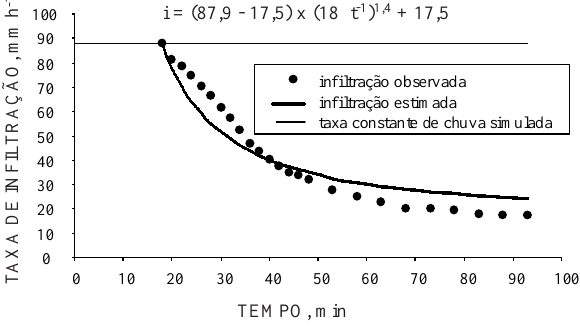
Figura 5. Taxas de infiltração observadas e estimadas para preparo convencional sob chuva simulada, com intensidade média constante de 87,9 mm h -1 . Médias de quatro repetições e duas observações por